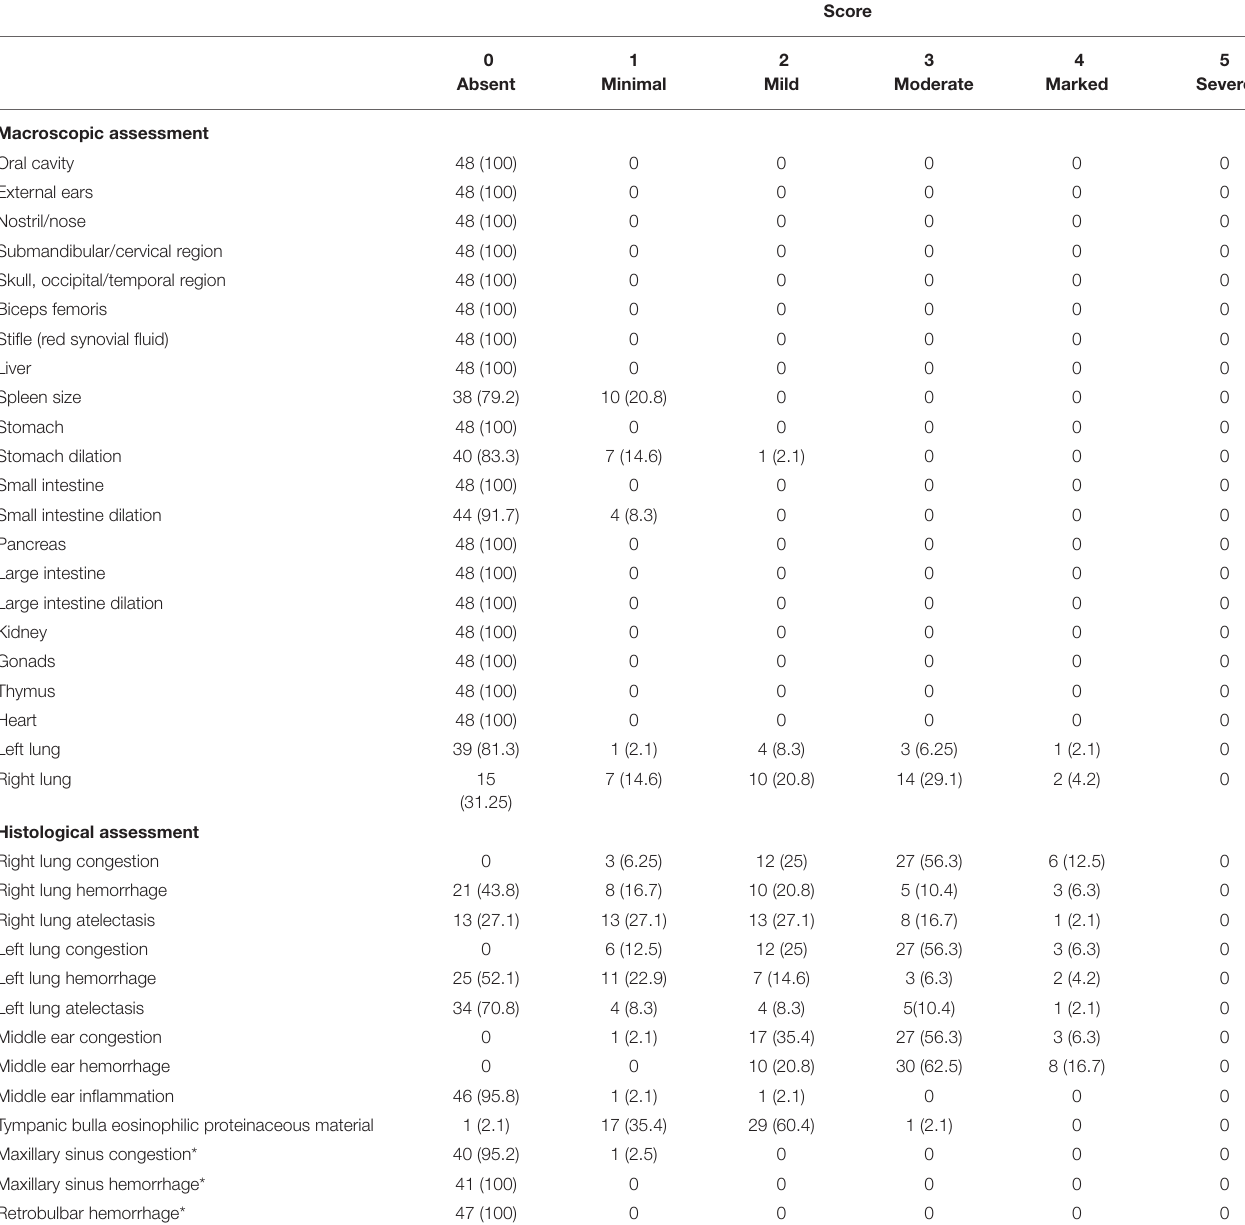
TABLE 3 | Summary table of findings from gross macroscopic assessment of external and internal structures and histological assessment of the lungs, middle ear and maxillary sinuses for mice undergoing decompression pooled across rate and shape given lack of statistical effects. Score 0